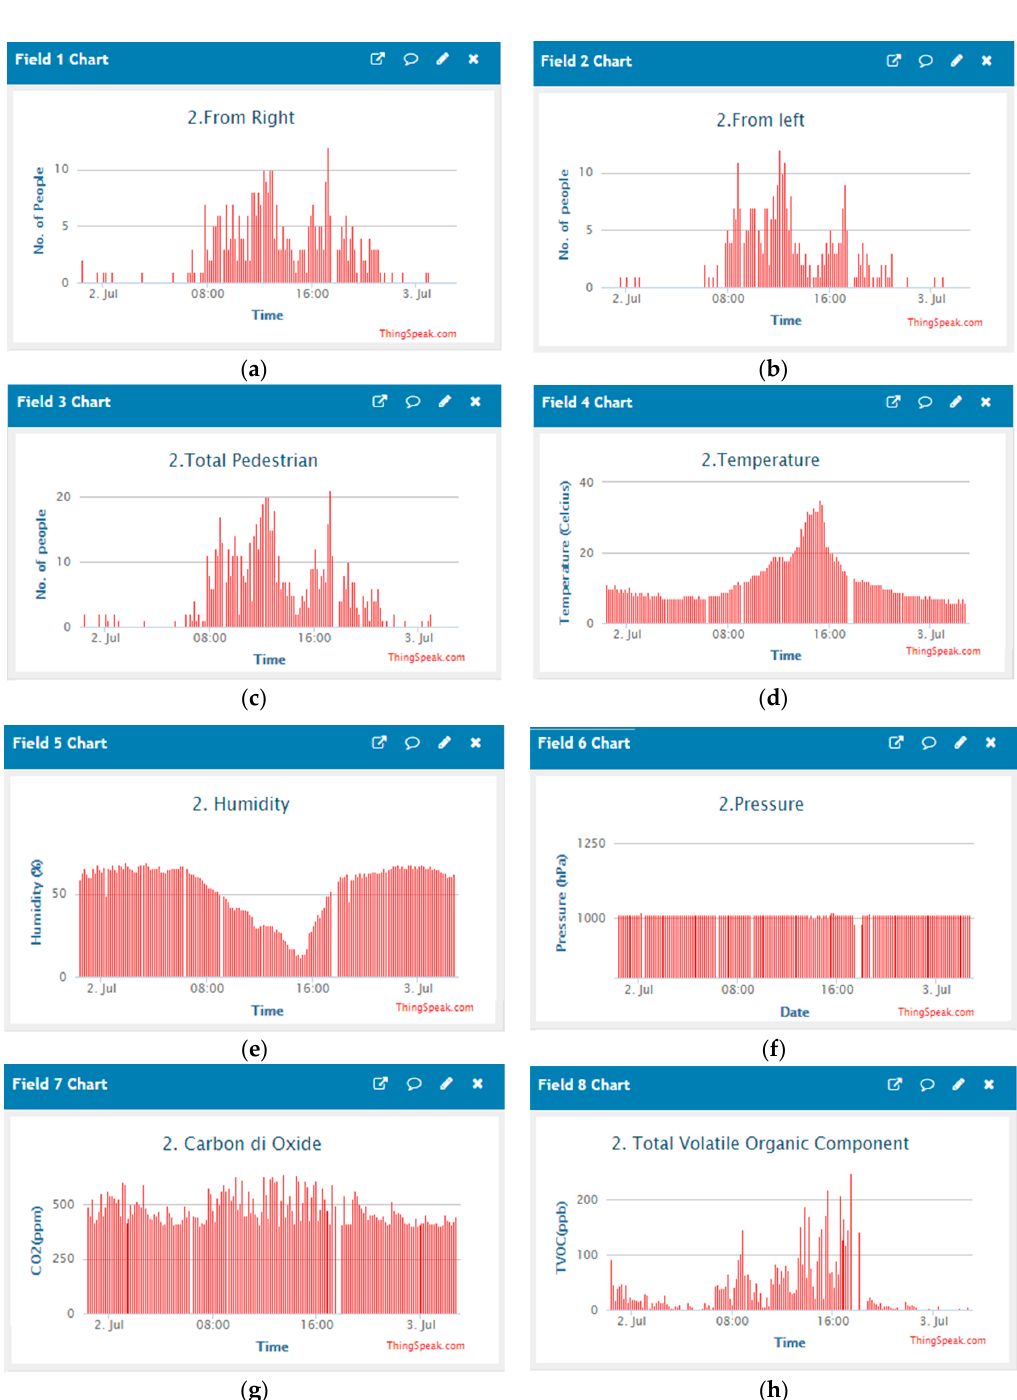
Figure 11. Transferred ( a ) pedestrians coming from the right, ( b ) pedestrians coming from the left, ( c ) total number of pedestrians, ( d ) temperature (°C), ( e ) humidity (%), (f) pressure (hPa), ( g ) carbon di oxide (ppm) and ( h ) total volatile organic component (ppb) data from the system to the Thingspeak cloud server.